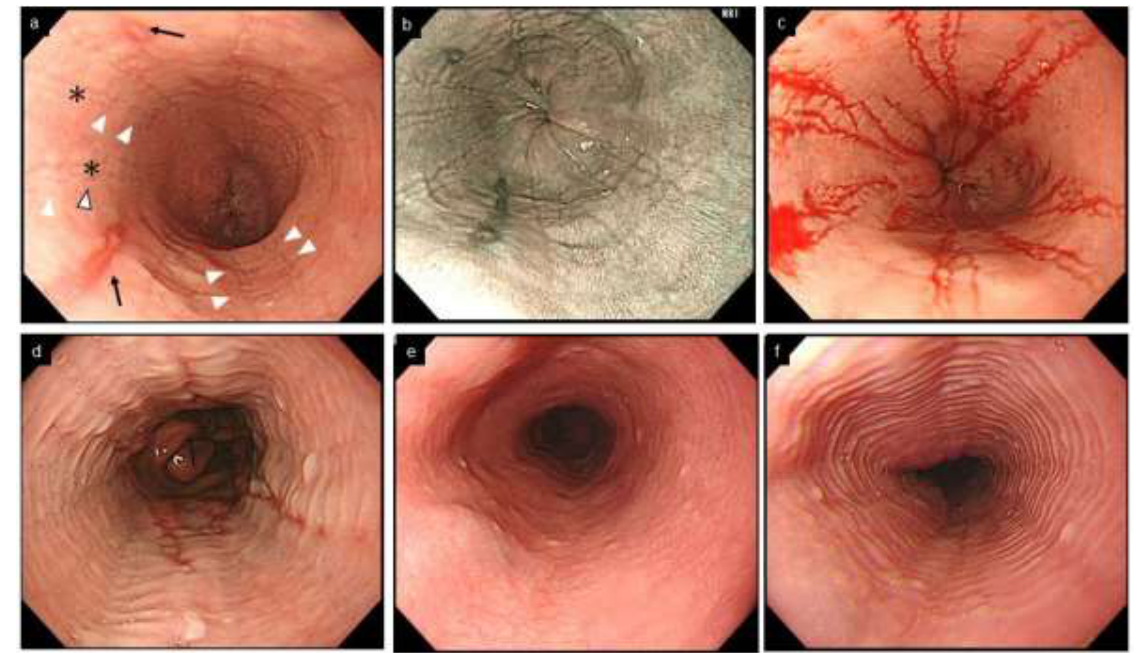
Figure 3. Esophageal erosion, furrows and rings in GERD and EoE, and feline esophagus in normal esophagus. ( a , b ). Coexistence of furrows in EoE (arrowhead) and longitudinal erosion in GERD (black arrow). Biopsy should be obtained just above on furrows (asterisk). ( c ). The visibility of furrows is enhanced after esophageal biopsies with blood pouring on the furrows. ( a – c , same patient; a , WLI; b , NBI). ( d ). Mild rings observed in erosive esophagitis. ( e , f ). Feline esophagus. Transient and sub- tle concentric rings are observed in the normal esophagus ( e , f , same patient). EoE,